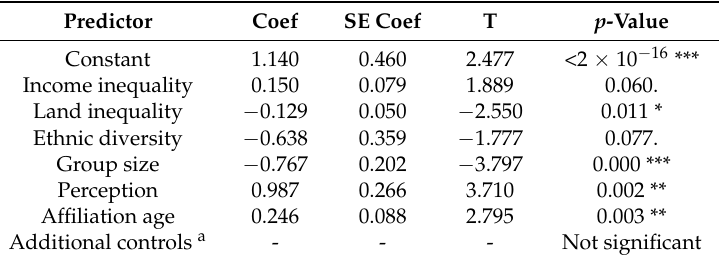
Table 8. GLS estimates for factors that influence participation in collective management of community